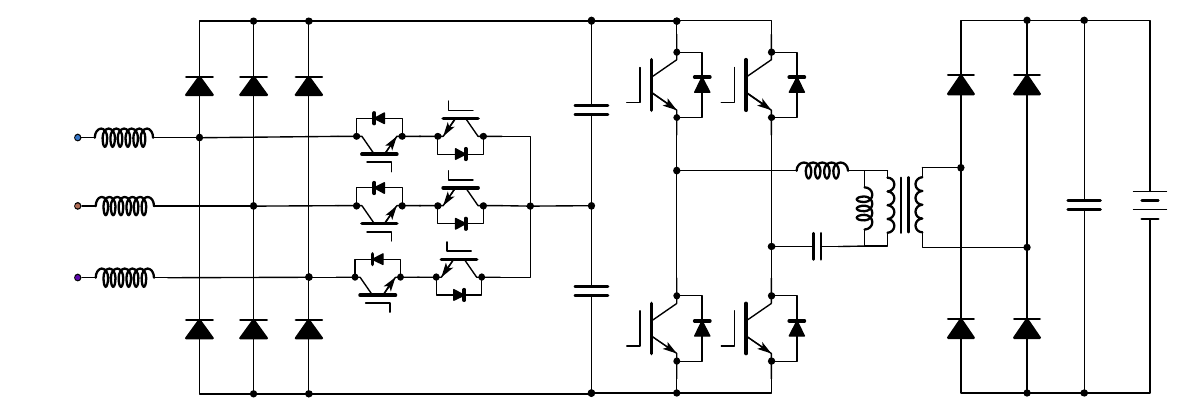
Energies 2023 , 16 , x FOR PEER REVIEW Figure 10. Modular 30 kW charger (proposed by Infineon Technologies). Figure 10. Modular 30 kW charger (proposed by Infineon Technologies). Figure 10. Modular 30 kW charger (proposed by Infineon Technologies).